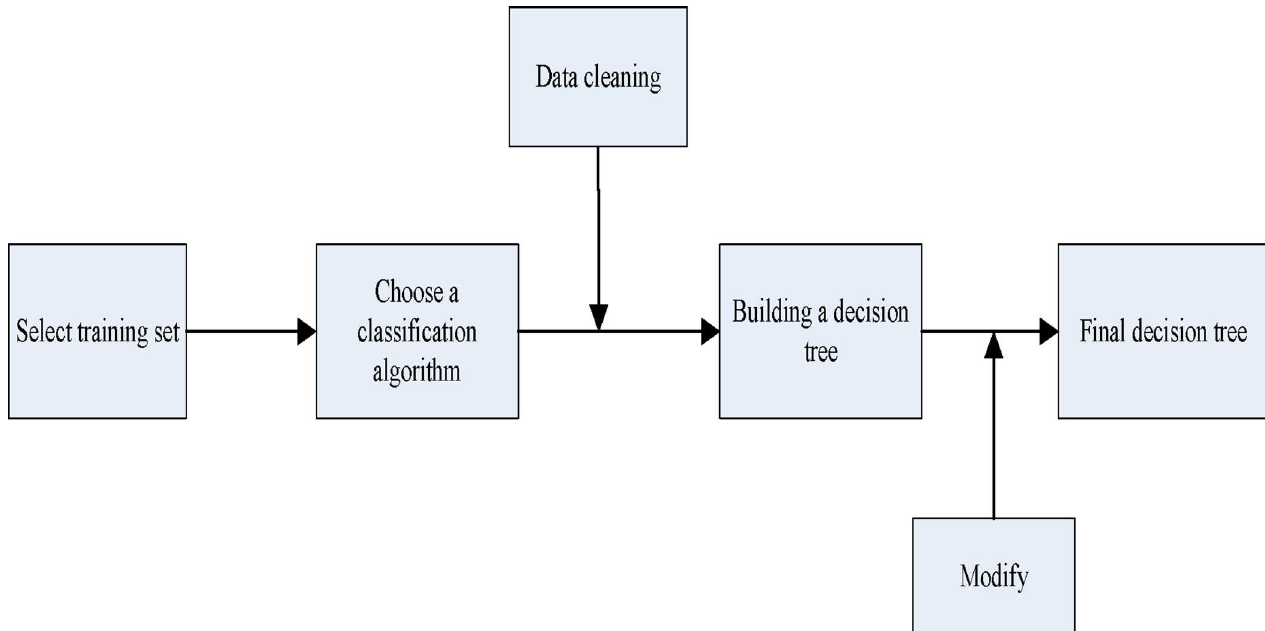
Fig 2. Decision tree generation algorithm and simplified